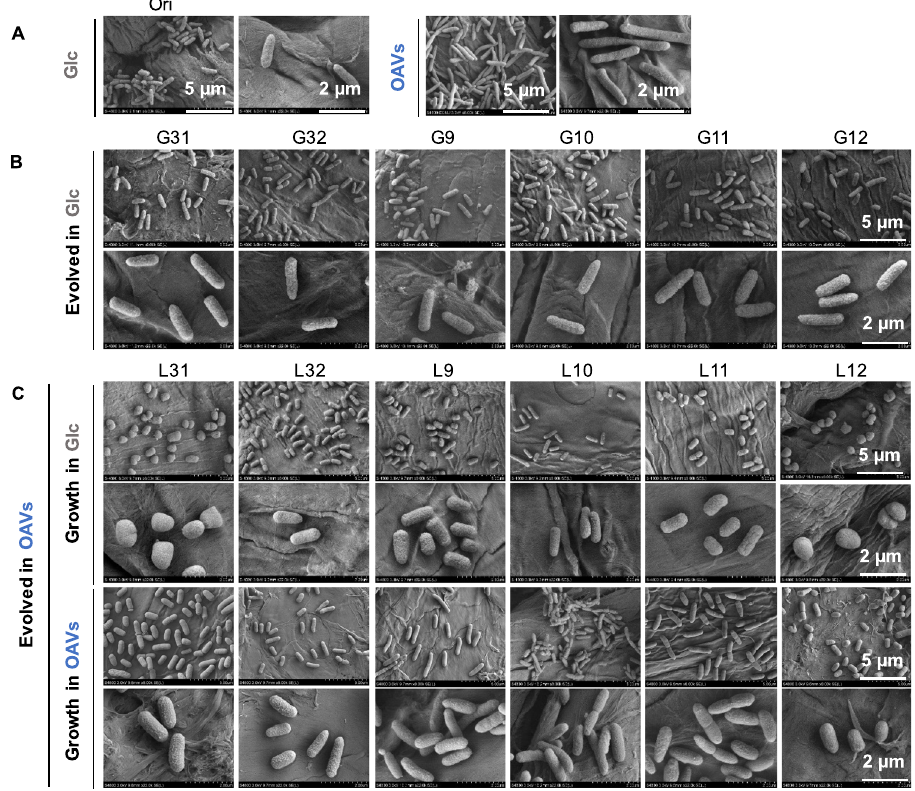
Fig. 2 Cell shapes imaged by SEM. A Single-cell images of the Ori in both glucose and OAVs. B The six lineages evolved in either glucose or OAVs ( C ) are shown on two size scales. Scale bars are indicated. The upper and bottom panels in ( C ) indicate the lineages evolved in OAVs newly grown in OAVs and glucose, respectively.